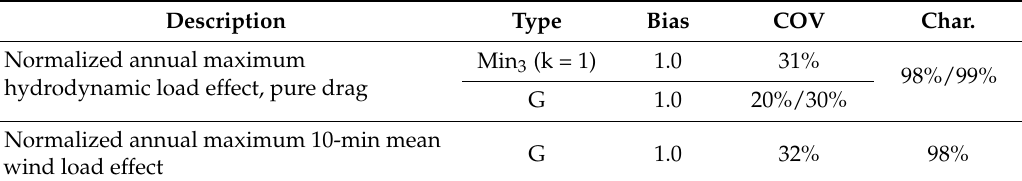
Table 6. Physical uncertainties from